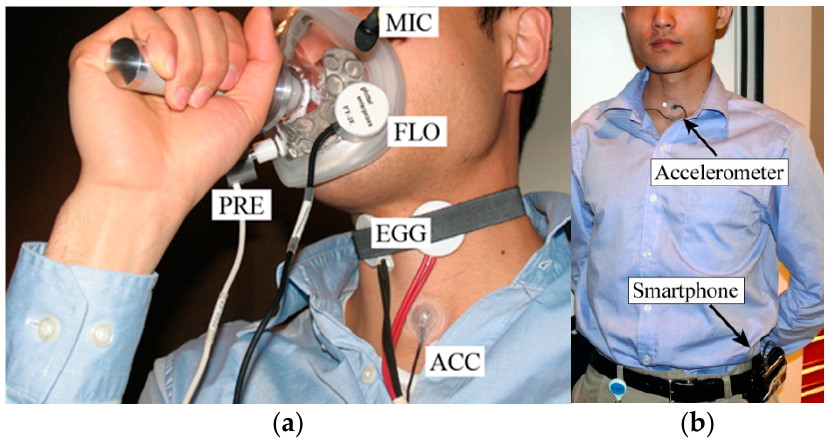
Figure 1. Data acquisition setups for ( a ) laboratory recordings of acoustic microphone (MIC), elec- troglottography (EGG), accelerometer (ACC), high-bandwidth oral airflow (FLO), and intraoral pressure (PRE); and ( b ) infield recording of the accelerometer sensor connected to a smartphone either placed in a belt holster or in a pocket. Reprinted with permission from Ref. [94]. Copyright 2013 IEEE.